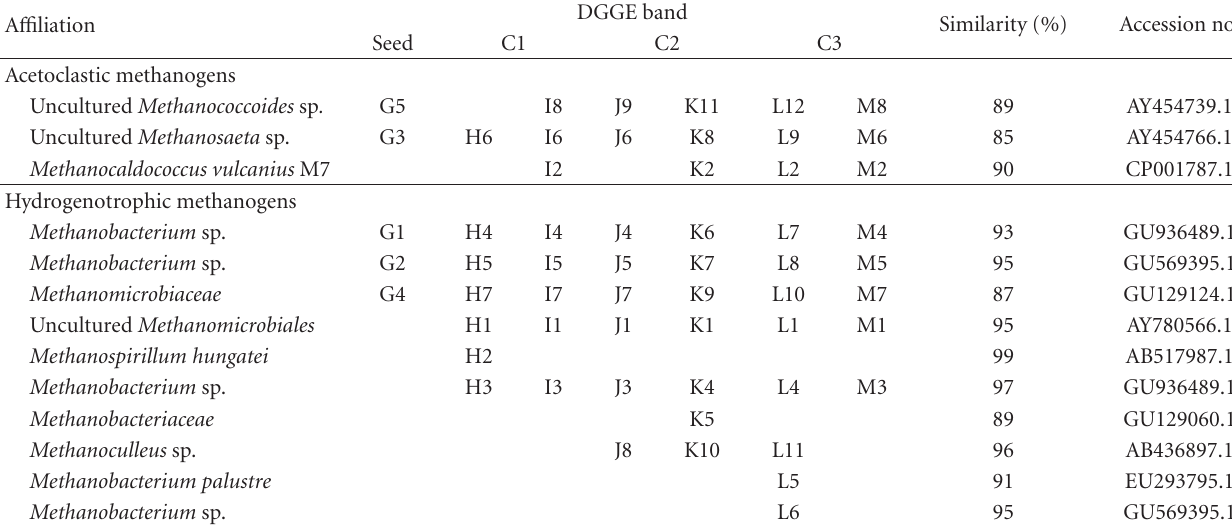
Table 3: The partial 16S rRNA gene sequences of ARC domain and organism with the best-matching sequences determined by BLAST